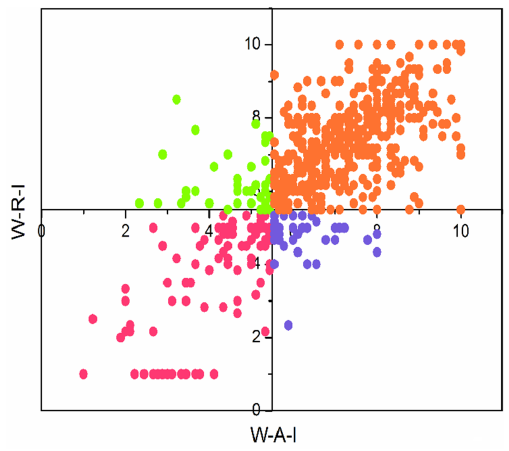
Figure 3. The four-quadrant analysis of the resources interaction ( R-I) and affection interaction ( A-I). Dissociated type: Miners of this type had low R-I and A-I, in which the miners easily destroyed their relationship with other roles. This kind of miner easily takes a passive and negative attitude toward their work. The type of miners is not satisfied with work, and they will become a dangerous group for safety and health in enterprises.